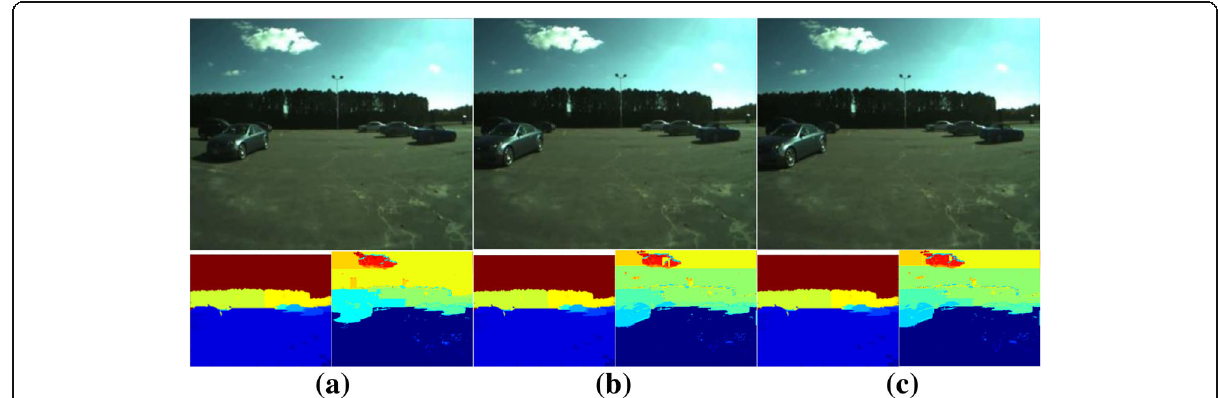
Fig. 14 Comparisons of depth map for Sequence_1 in [6]. a . Frame 85. b Frame 93. c Frame 94. Images from upper, left to right are original images, ground truth, and depth maps of the proposed method